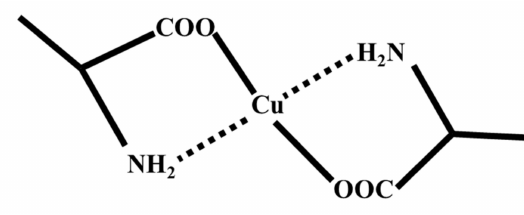
Figure 3. Copper ion and amino acid binding with